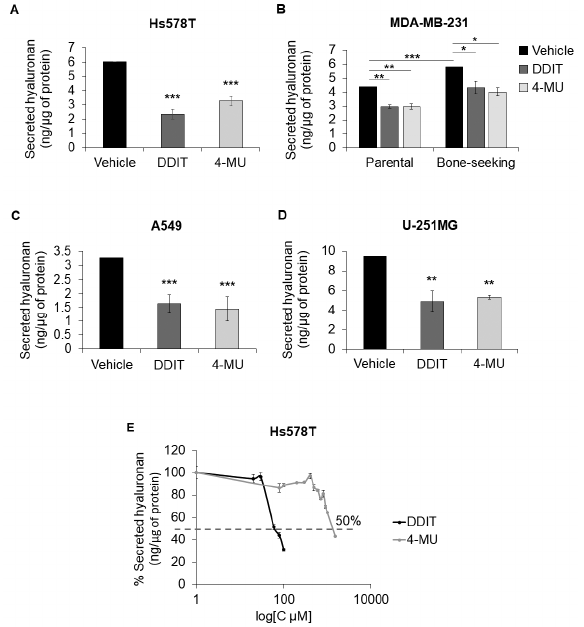
Figure 3. DDIT is a more potent inhibitor of hyaluronan synthesis than 4-MU. Quantification of hyaluronan secreted by Hs578T breast cancer cells ( A ), MDA-MB-231 parental and bone-seeking breast cancer cells ( B ), A549 lung adenocarcinoma cells ( C ) and glioma U-251MG cells ( D ) after treatment with vehicle, DDIT or 4-MU (1 mM) in serum-free medium. Hs578T, MDA-MB-231 and A549 were treated with 80 µ M whereas U-251MG was treated with 100 µ M DDIT. ( E ) Inhibition of hyaluronan synthesis after treatment with various concentrations of DDIT (0–100 µ M) or 4-MU (0–1000 µ M). Statistical significance is depicted as asterisks (*, p < 0.05; **, p < 0.01; ***, p < 0.001).